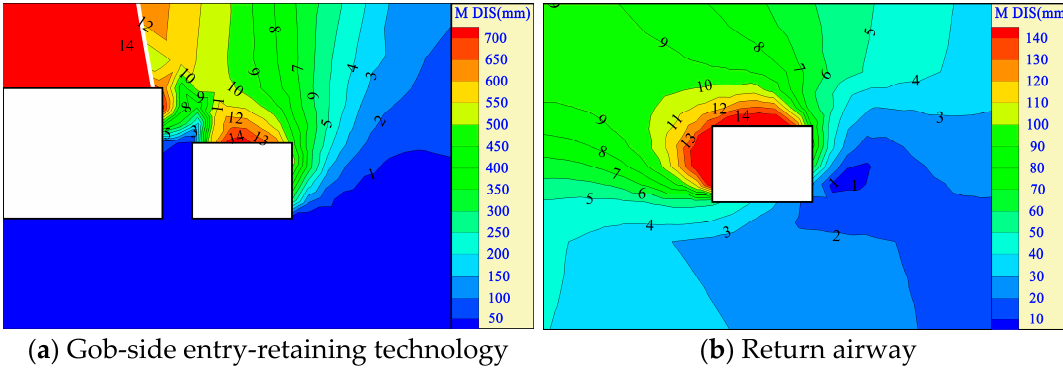
Figure 14. Plastic development of surrounding rocks after roof cutting.